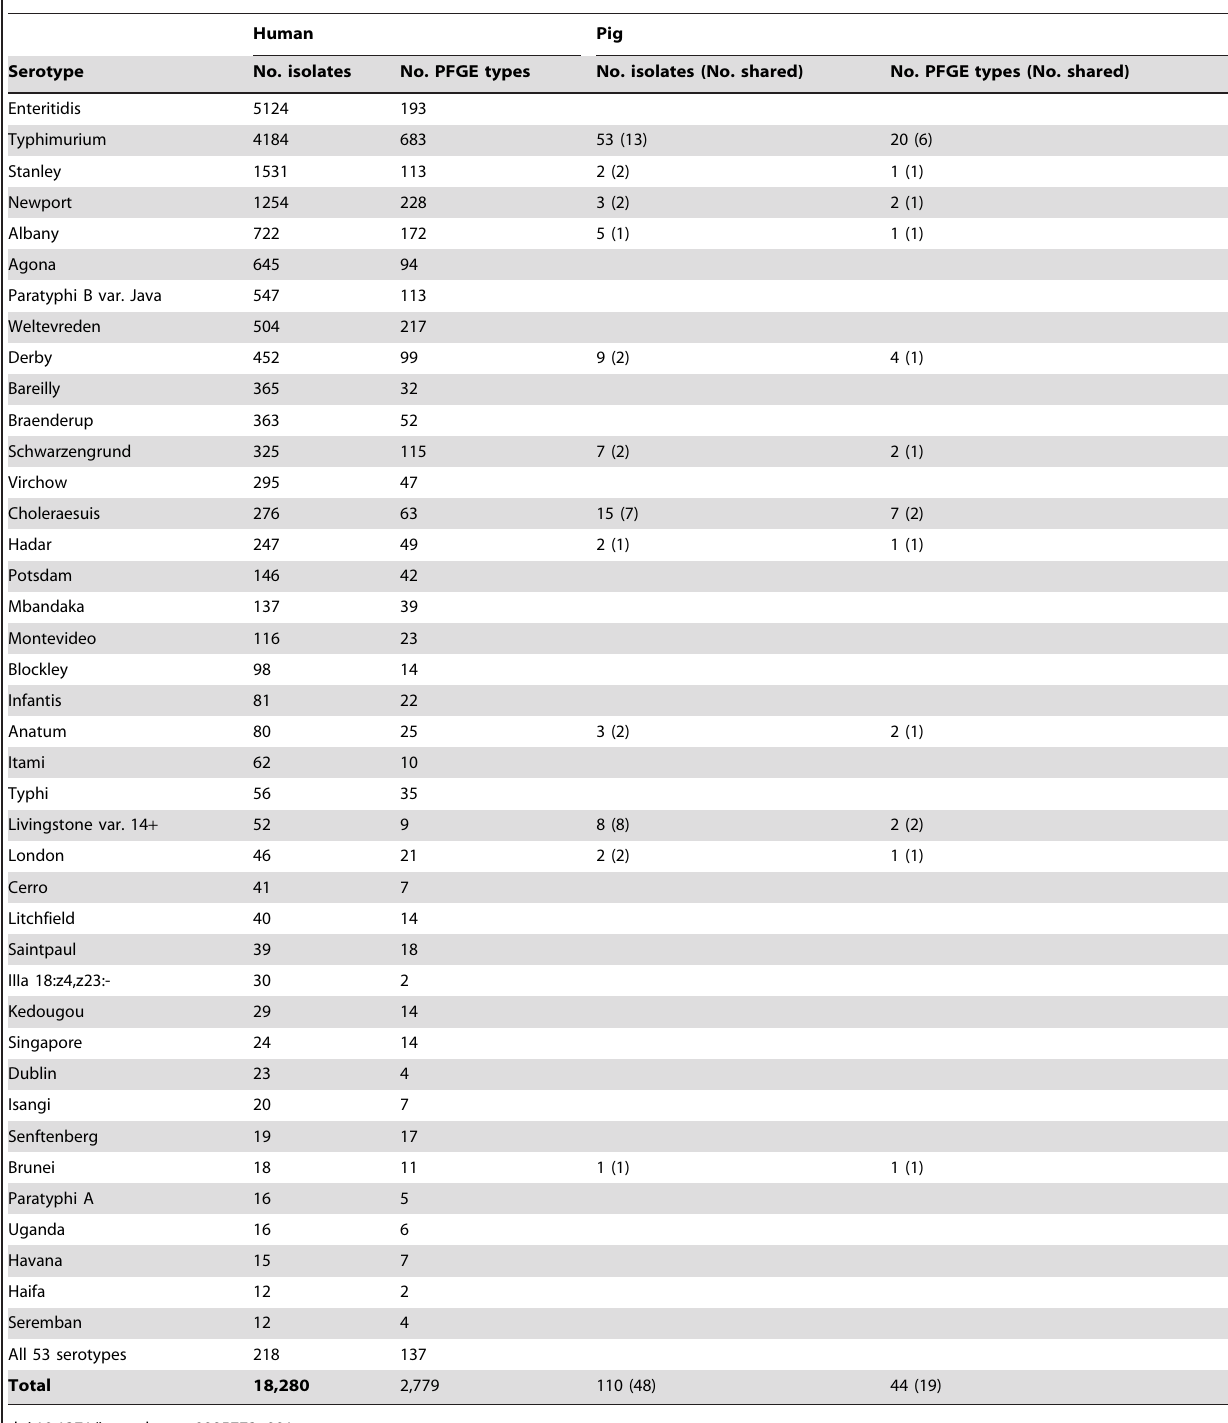
Table 1. Salmonella isolates from humans and pigs.